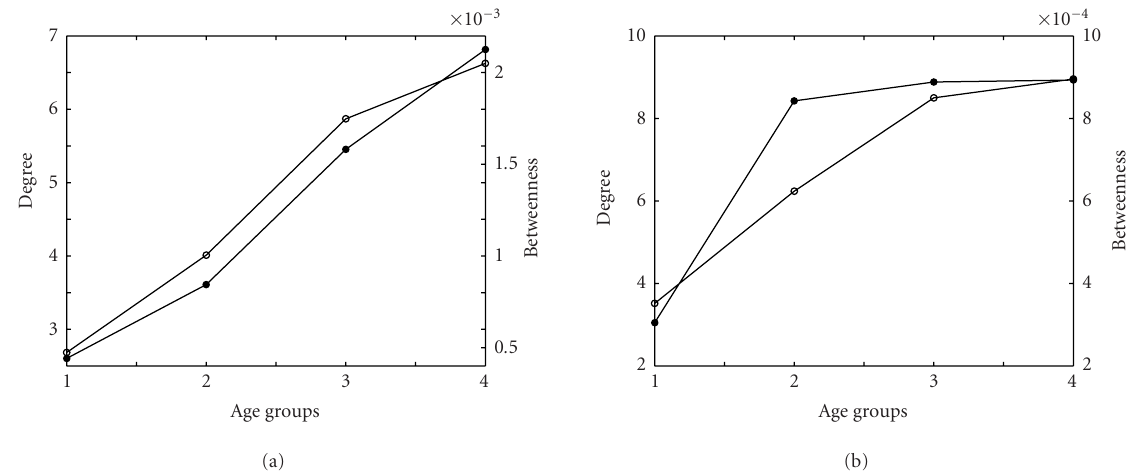
Figure 5. Degree and betweenness dependence of protein age. Average degree (left axis, open circle) and average betweenness (right axis, filled circle) of the four age groups of the yeast proteins. Group 1 contains proteins existing only in S cerevisiae and hence supposed to be the youngest while group 4 contains proteins existing in the all four branches and hence the oldest [32]. (a) Core data. (b) Full DIP